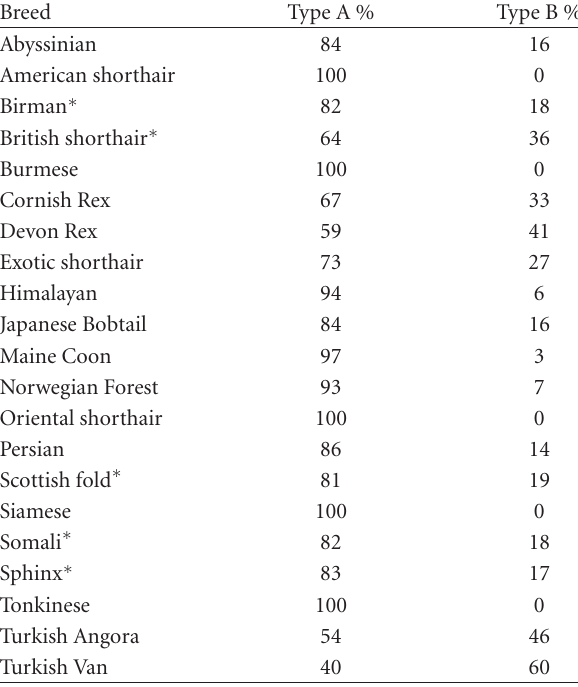
Table 3: Breed distribution of feline blood types; ∗ breeds with reported type AB cats (Adapted from Giger [36] and Arikan and coworkers [38]).